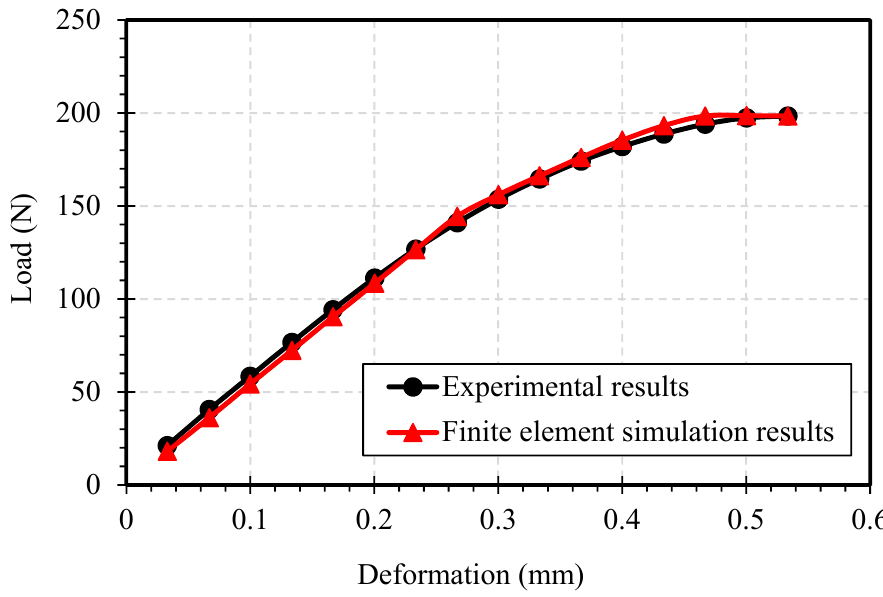
Figure 8. Plot of load vs deformation of tension test for experimental and finite element simulation.